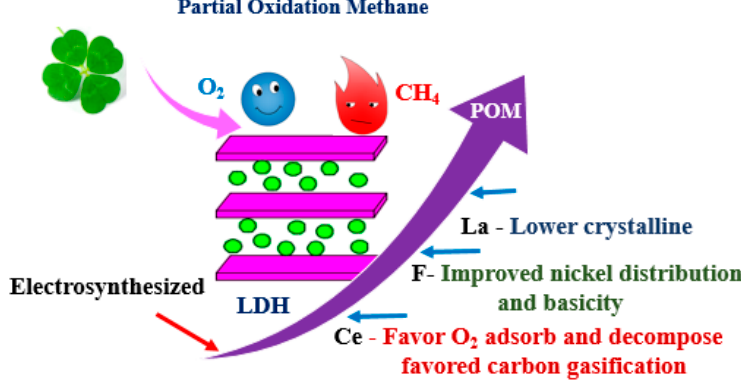
Figure 9. The application of LDHs in partial oxidation of methane. POM, partial oxidation of